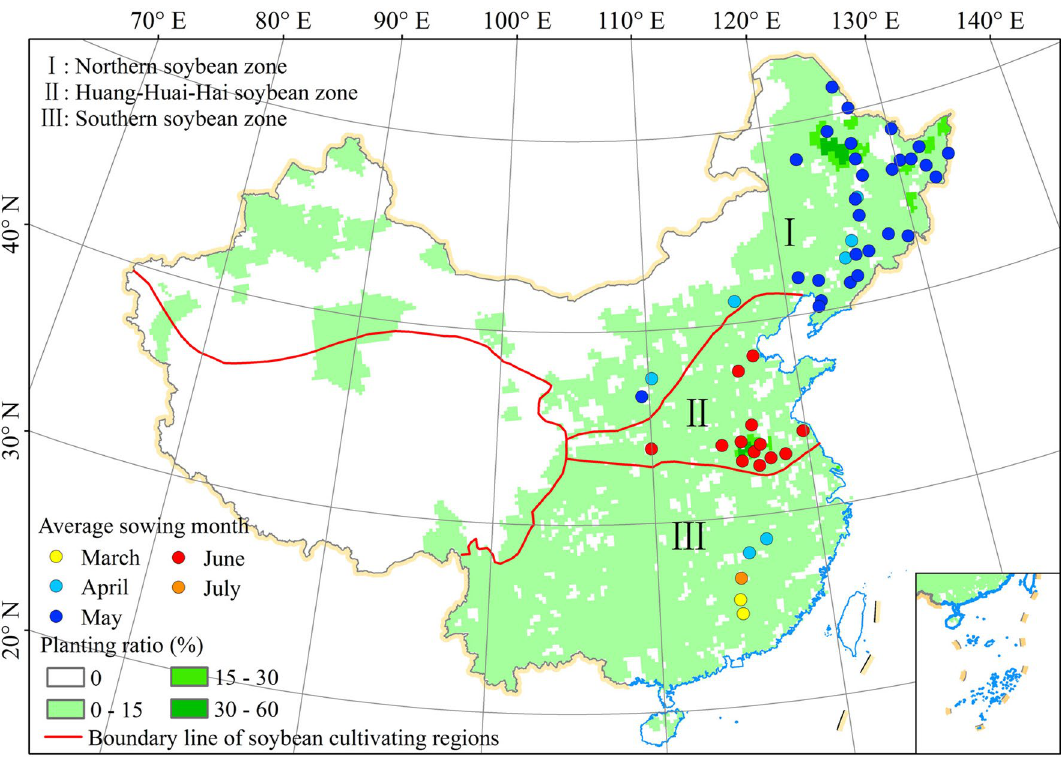
Figure 6. Spatial distribution of three soybean cultivation regions and 51 agro-meteorological stations in China. The map was generated by ArcGIS 10.2 software (https:// www. esri.